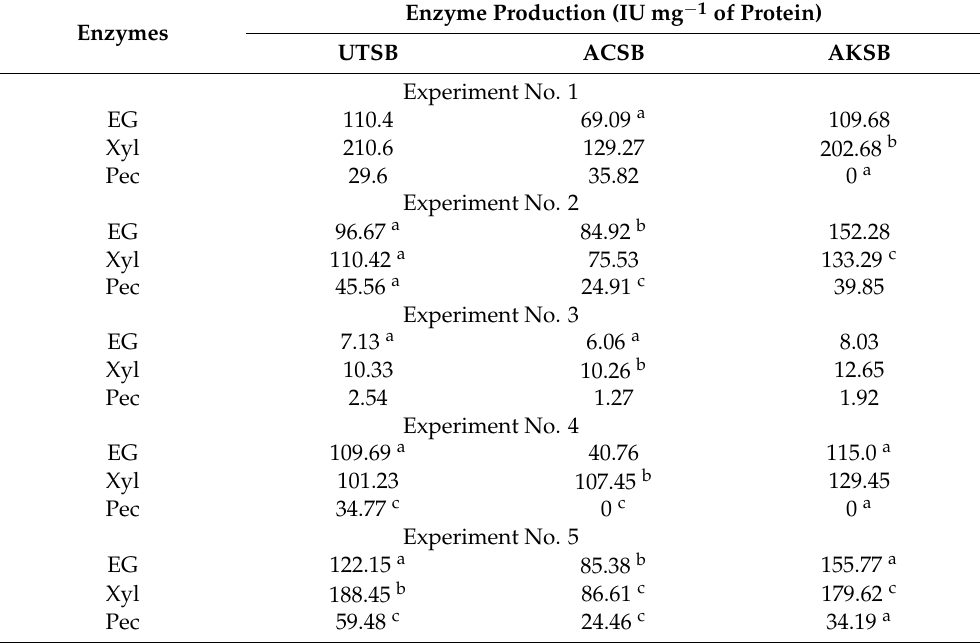
Table 5. Production of endoglucanase (EG), xylanase (Xyl) and pectinase (Pec) by the co-culture of the bacterial strains (as mentioned in the methods section) under SSF of untreated (UTSB), acid pre-treated (ACSB) and alkali pre-treated SB